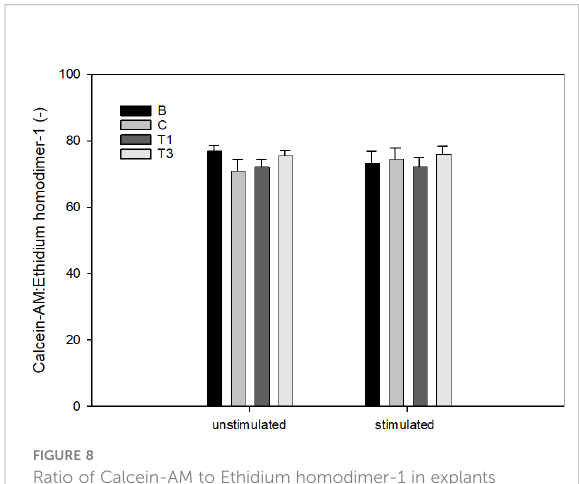
FIGURE 8 Ratio of Calcein-AM to Ethidium homodimer-1 in explants cultured for 96 h For the fi nal 72h, explants were conditioned with wheatgrass extract at 0 (B), 5 (T1) or 15 µg/mL (T3). For the fi nal 48h, explants were stimulated with LPS [0 (unstimulated) or 10 µg/mL